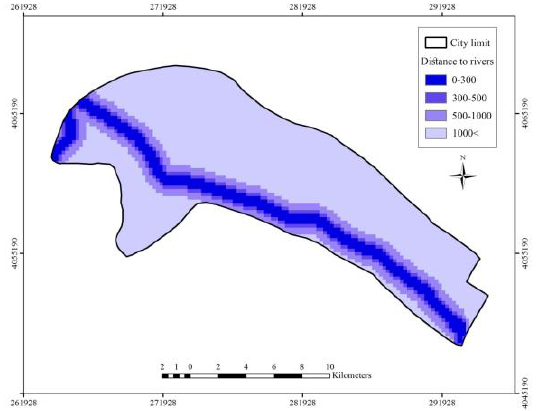
Figure 9. The map of main rivers in the study area and classified distances from them (The unit of distance is meter)